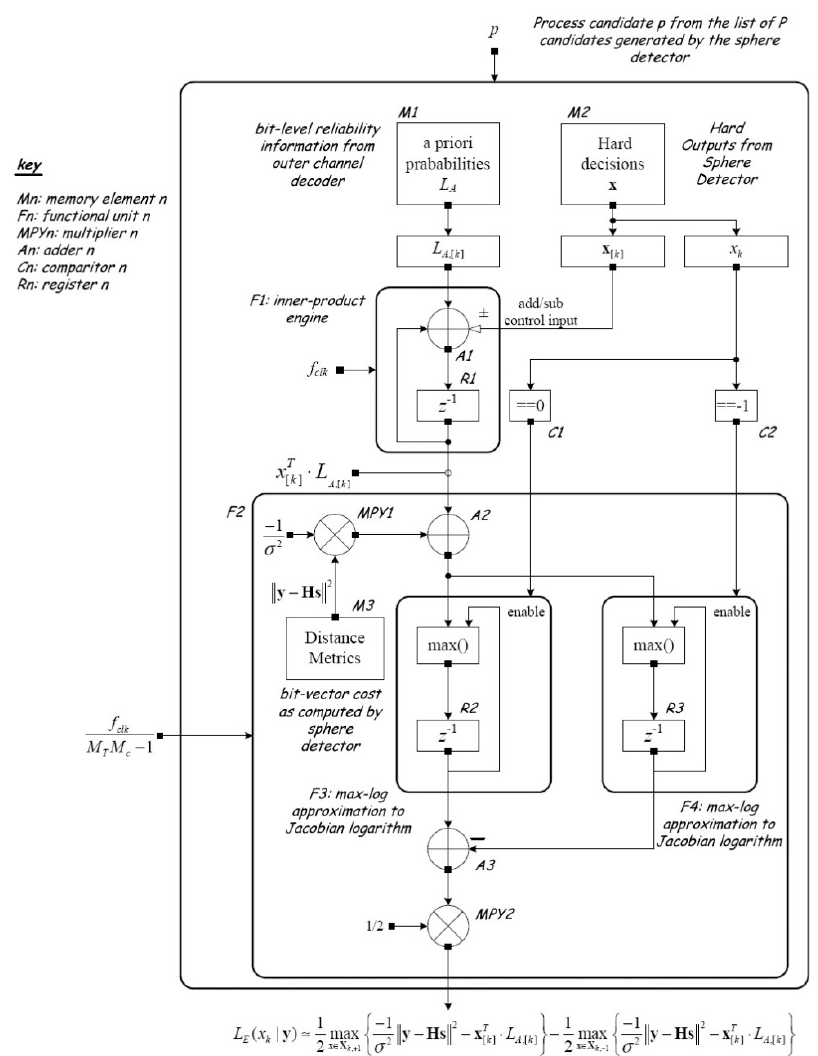
Figure 11. A scalable architecture of spatial multiplexing MIMO decoders for field-programmable gate arrays (FPGAs) [39].